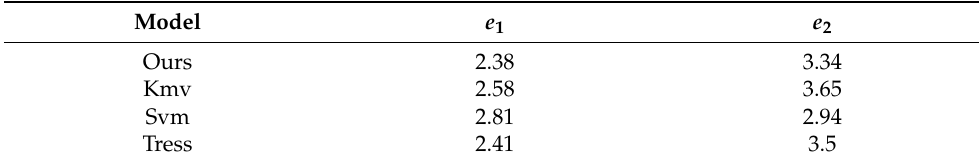
Table 3. Error comparison of different data sets and